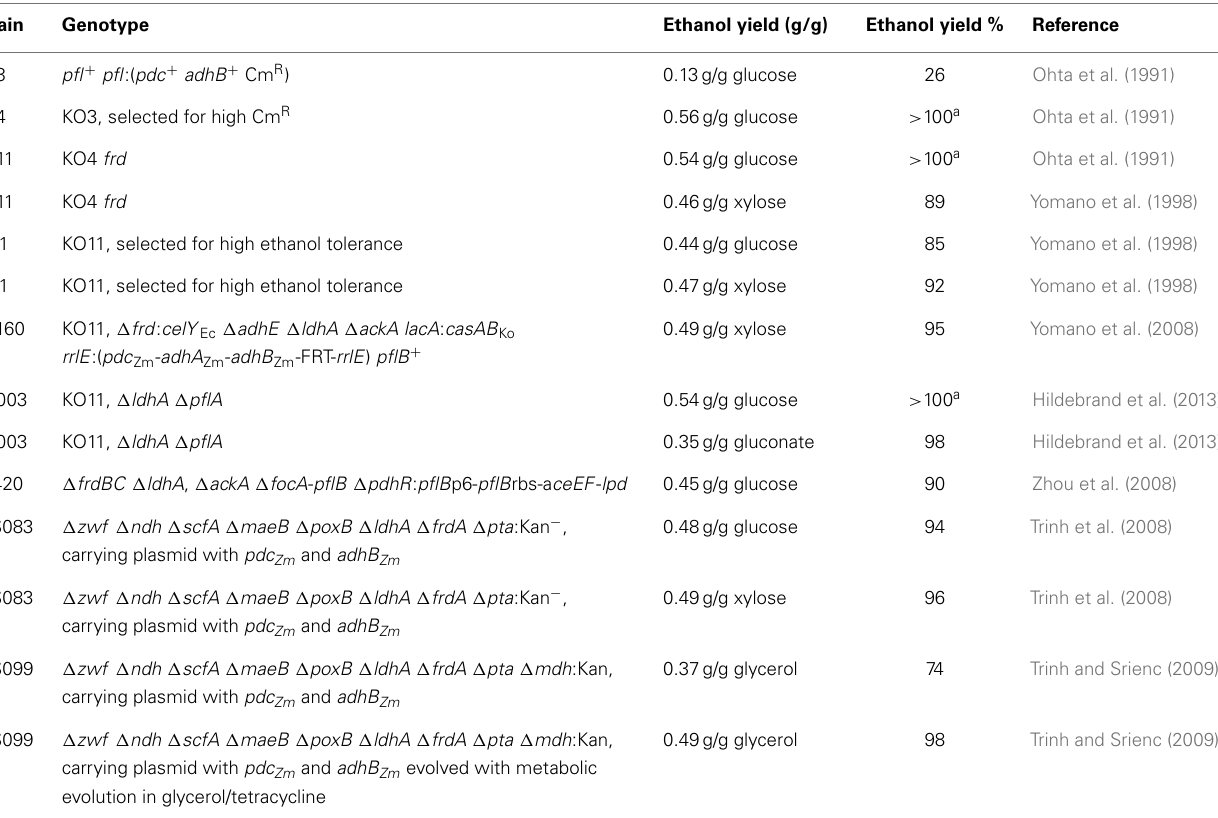
Table 1 | Comparison of ethanologenic E. coli strains